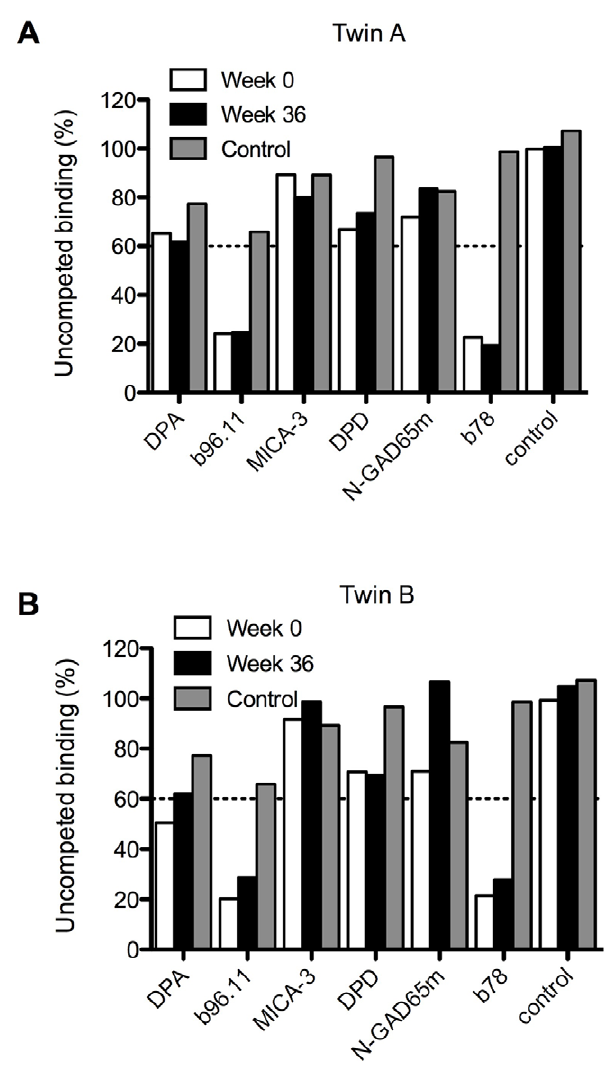
Figure 4. Antibodies specific to GAD65 conformational epi- topes are resistant to rituximab treatment. Binding of IgG from twin A (A) and twin B (B) isolated at t=0 and at t=36 weeks to radiolabeled GAD65 was analyzed in the presence of recombinant Fab derived from GAD65-specific monoclonal antibodies. Grey bars represent competitive binding of healthy control IgG. DPA, b96.11, MICA-3, DPD, N-GAD65mAb, and b78 are monoclonal antibodies specific for GAD65. The control Fab does not bind GAD65.